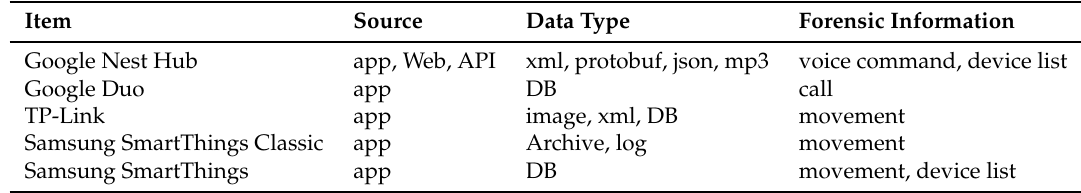
Table 1. Summary of the data considered in the